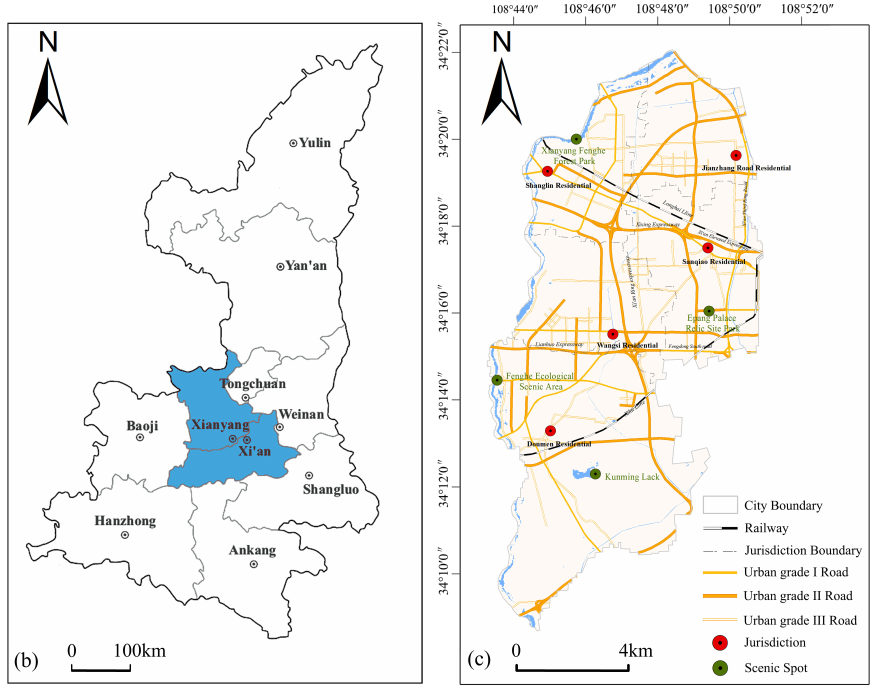
Figure 1. Research location map. ( a ) Shannxi province in China; ( b ) Xianyang and Xi’an in Shannxi ( c ) Fending.